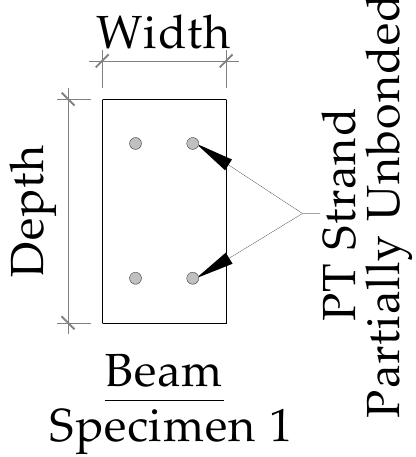
Figure 14. PT strand (partially unbonded).